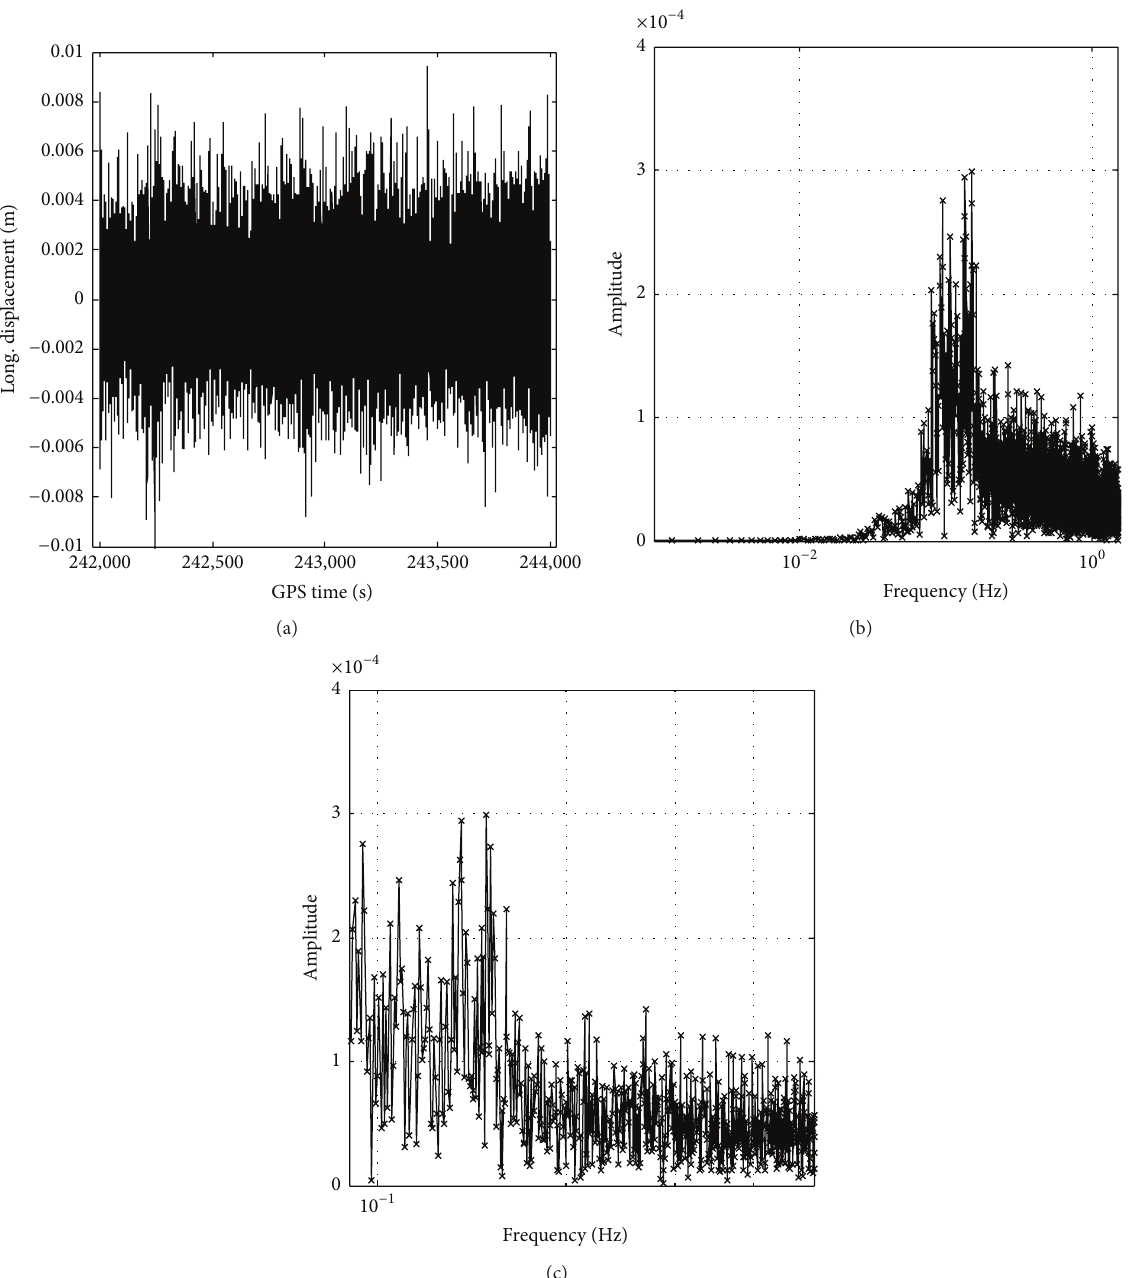
Figure9:Thefilteredlongitudinaldisplacements(a),correspondingvibrationfrequency((b),full-scaleband),andzoom-inofhighfrequency component